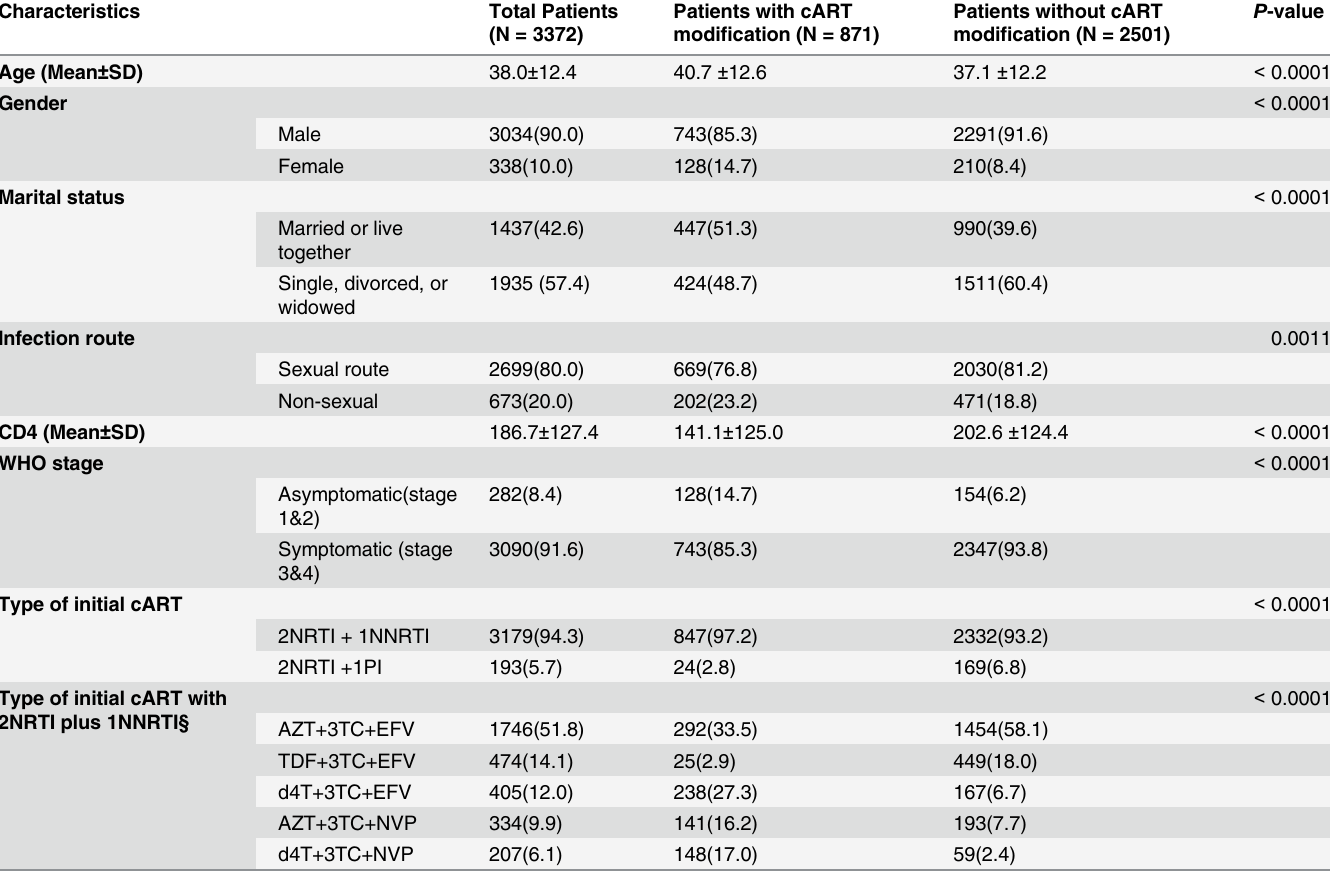
Table 1. Patients ’ characteristics and analysis of the demographics and clinical data between cART modification and none cART modification a .